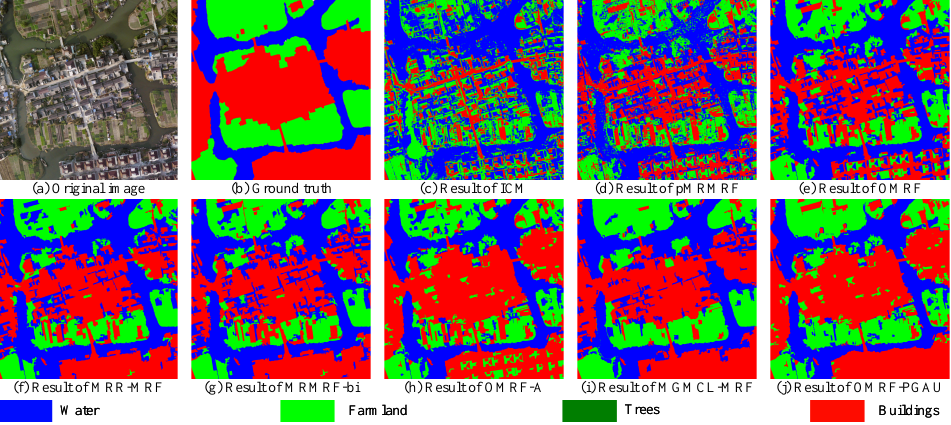
Figure 16. Semantic segmentation results for medium size areail image.